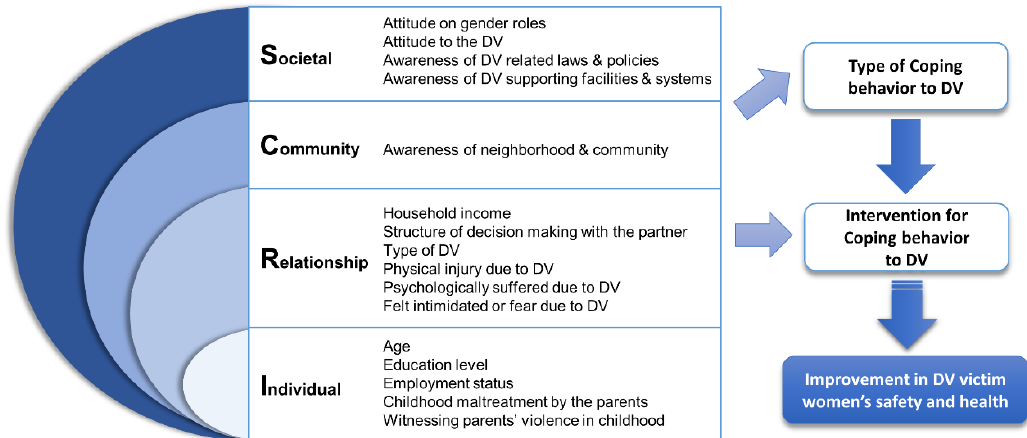
Figure 1. Conceptual framework. DV-Domestic Violence. IPV against women has been imperceptible in national and international